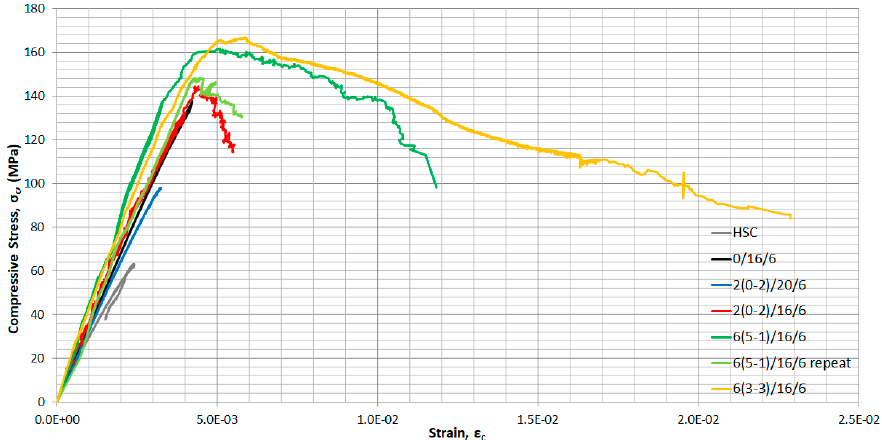
Figure 9. Compressive stress–strain curves from cylinder compression test.